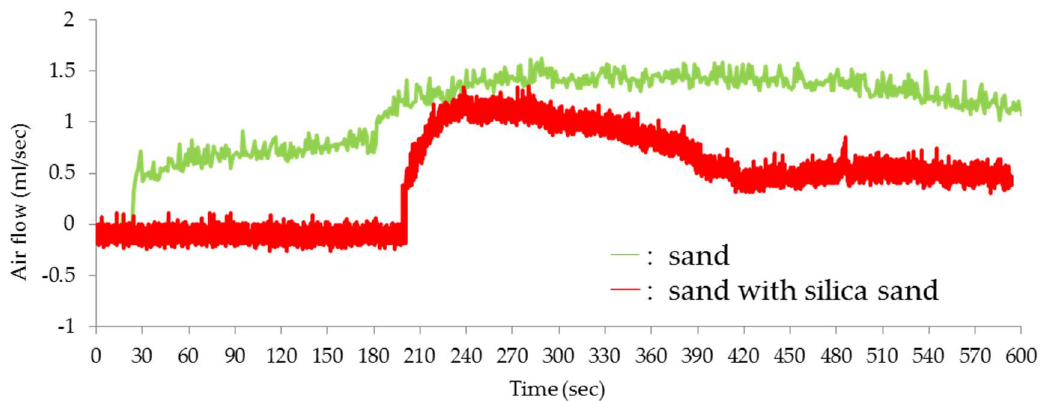
Figure 4. Air flow results. The volume of air flow in the case with silica sand was smaller than that in the case with no silica sand for the entirety of the experiment, although the volume of air flow in the case with silica sand increased after approximately 200 s.